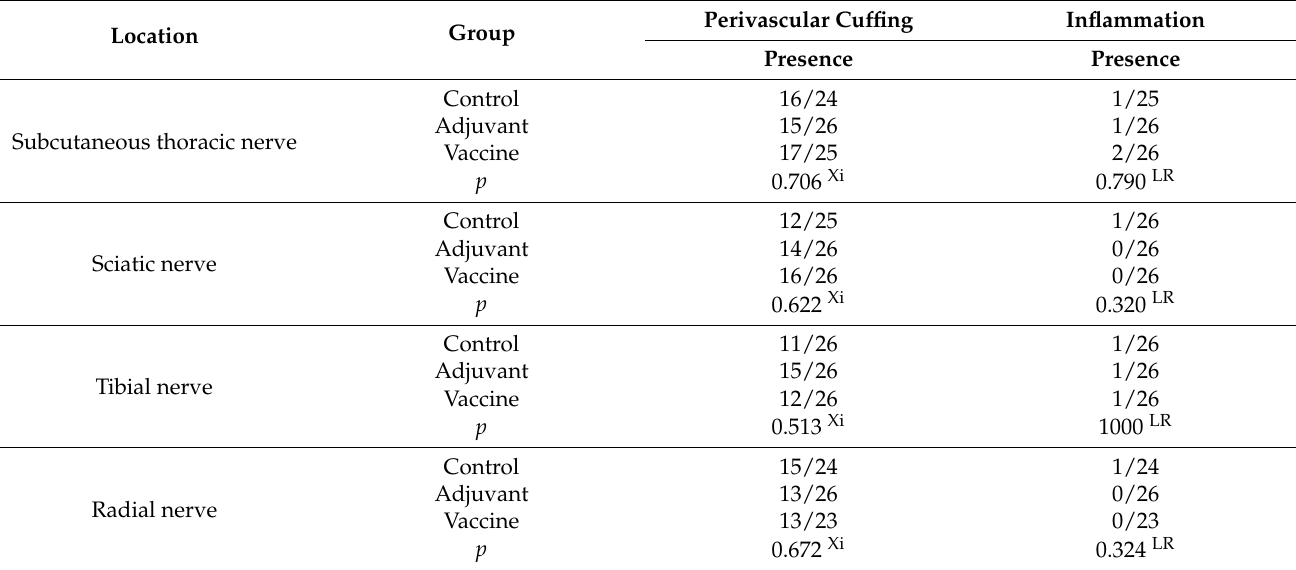
Table A15. Histopathological findings in the peripheral nervous system in Control, Adjuvant-only and Vaccine groups of all Flocks grouped together. Data provided as animals with the referred histological lesion relative to the total number of animals analyzed. Methodology of histopathological evaluation is detailed in Tables A3–A11 (Appendix